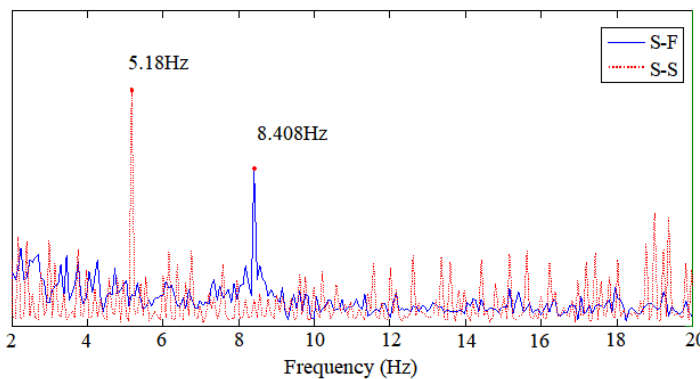
Figure 8. PSD of the UPVC risers with two different end conditions (U = 0.6 m/s).